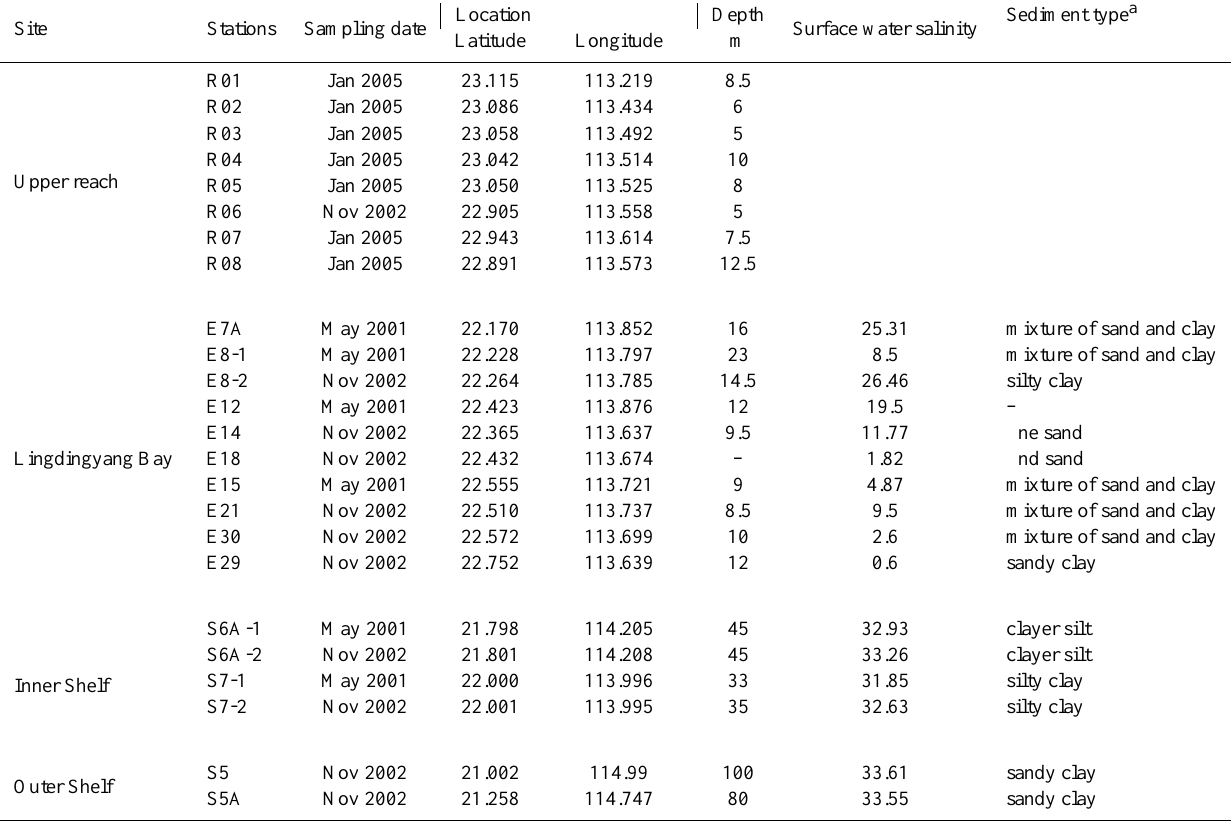
Table 2. Geochemical data for surface sediments in the upper reach of the Pearl River Estuary, Lingdingyang Bay and the SCS